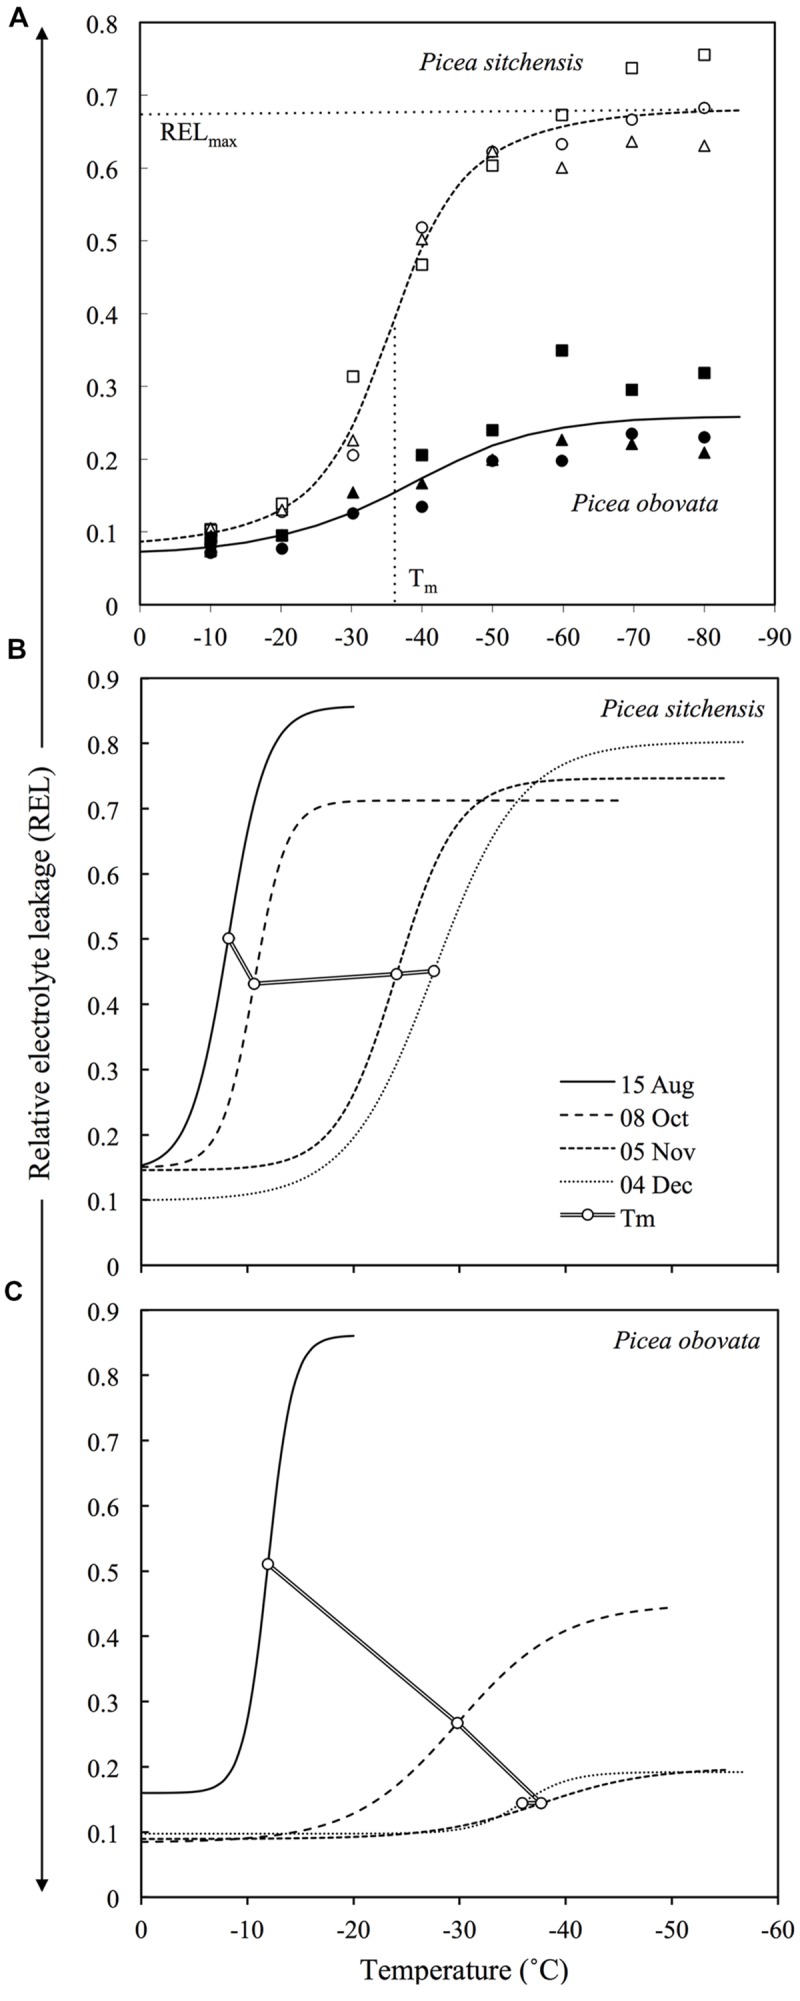
(A) Example of REL data and temperature response curves for fully acclimated needles from MLT and ELT tolerant species (Picea sitchensis and Picea obovata, respectively). Different symbols represent three different trees for each species. Horizontal and vertical dashed lines show location of the parameters RELmax and Tm, respectively for P. sitchensis (adapted from Strimbeck et al., 2007). (B,C) Changes in temperature response curves and Tm during acclimation for P. sitchensis
(B) and P. obovata
(C) (adapted from Strimbeck et al., 2008).